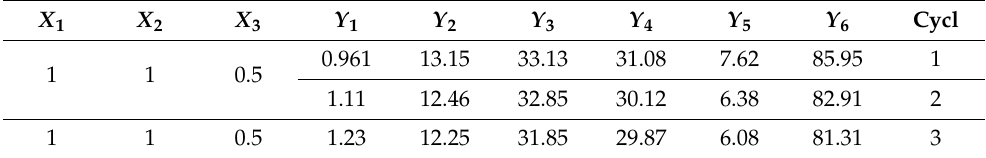
Table 7. The optimized parameters for maximum values of glycerol conversion and selectivity in